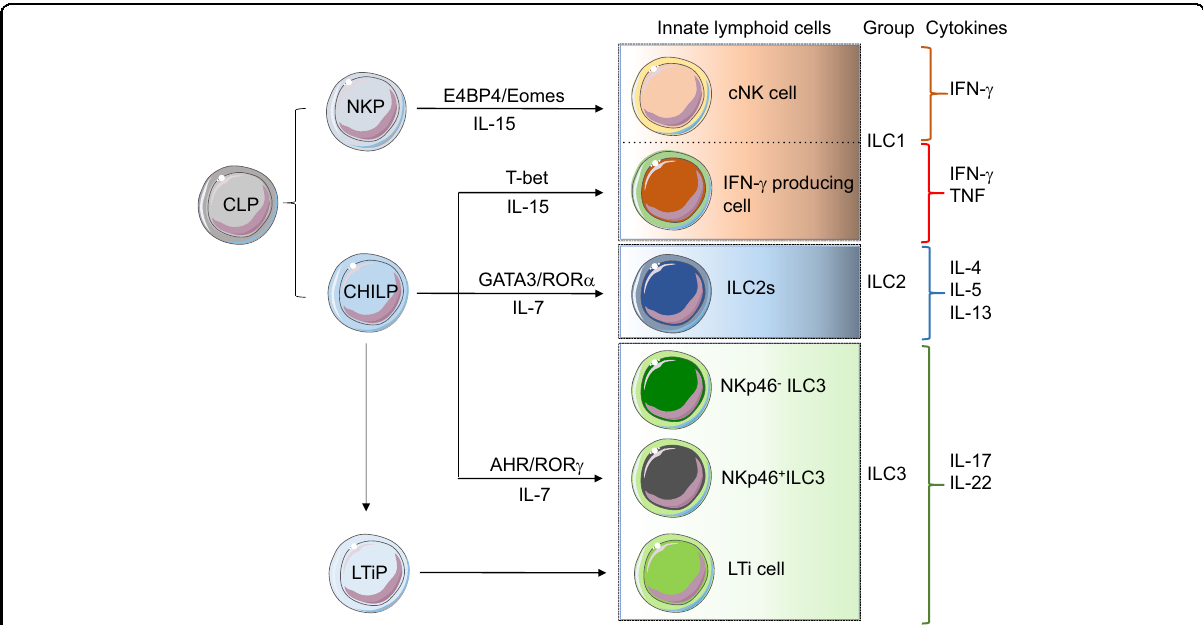
Fig. 1 Characteristics of ILC subsets. Outline of ILC differentiation pathways with the respective transcription factors required for their differentiation and cytokines produced by ILC subsets. CLP common lymphoid progenitor, NKP NK cell progenitor, CHILP common helper-like innate lymphoid precursor, E4BP4 E4 promoter-binding protein 4 (also known as NFIL3), ROR RAR-related orphan receptor, AHR aryl hydrocarbon receptor, cNK conventional NK cell, LTiP lymphoid tissue inducer projenitors, LTi lymphoid tissue